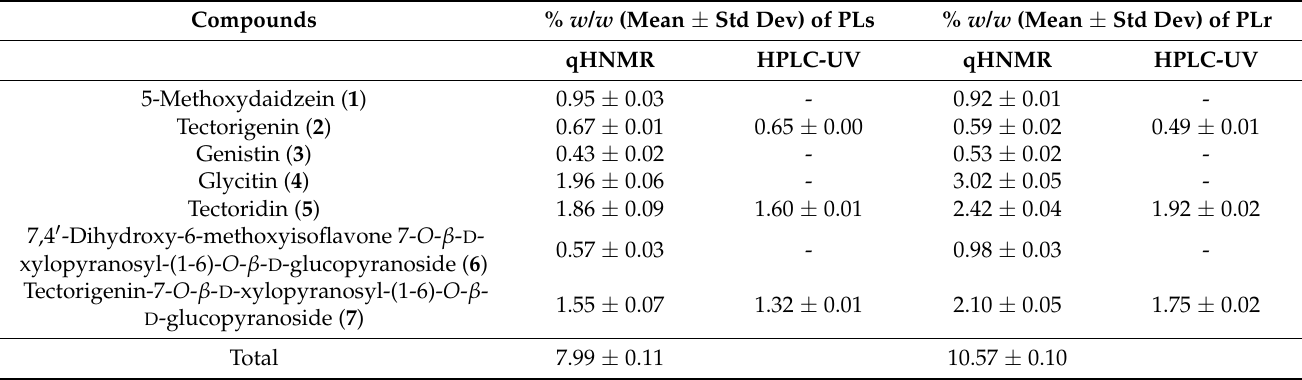
and HPLC methods. Samples were prepared and analyzed in triplicate ( n =